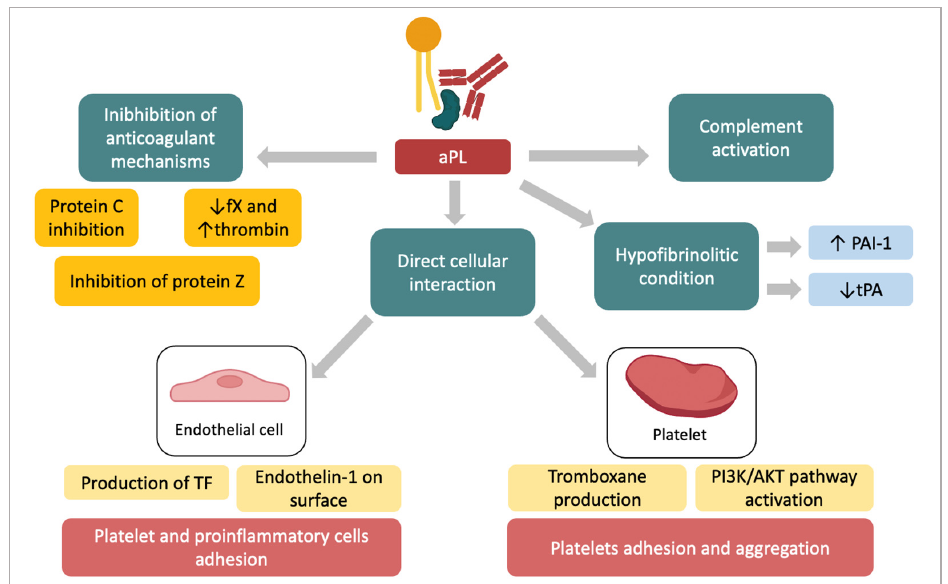
Figure 1. Antiphospholipid antibodies (aPL) prothrombotic activity. aPLs interact with several coagulation cascade proteins, reduce fibrinolytic activity, activate complement and have a direct effect on endothelial cells and platelets. All of these mechanisms finally contribute to the characteristic thrombotic events observed in APS. aPLs = antiphospholipid antibodies; PAI-1 = inhibitor of plasminogen type 1; tPA = activator of tissue plasminogen; TF = tissue factor; fX = factor